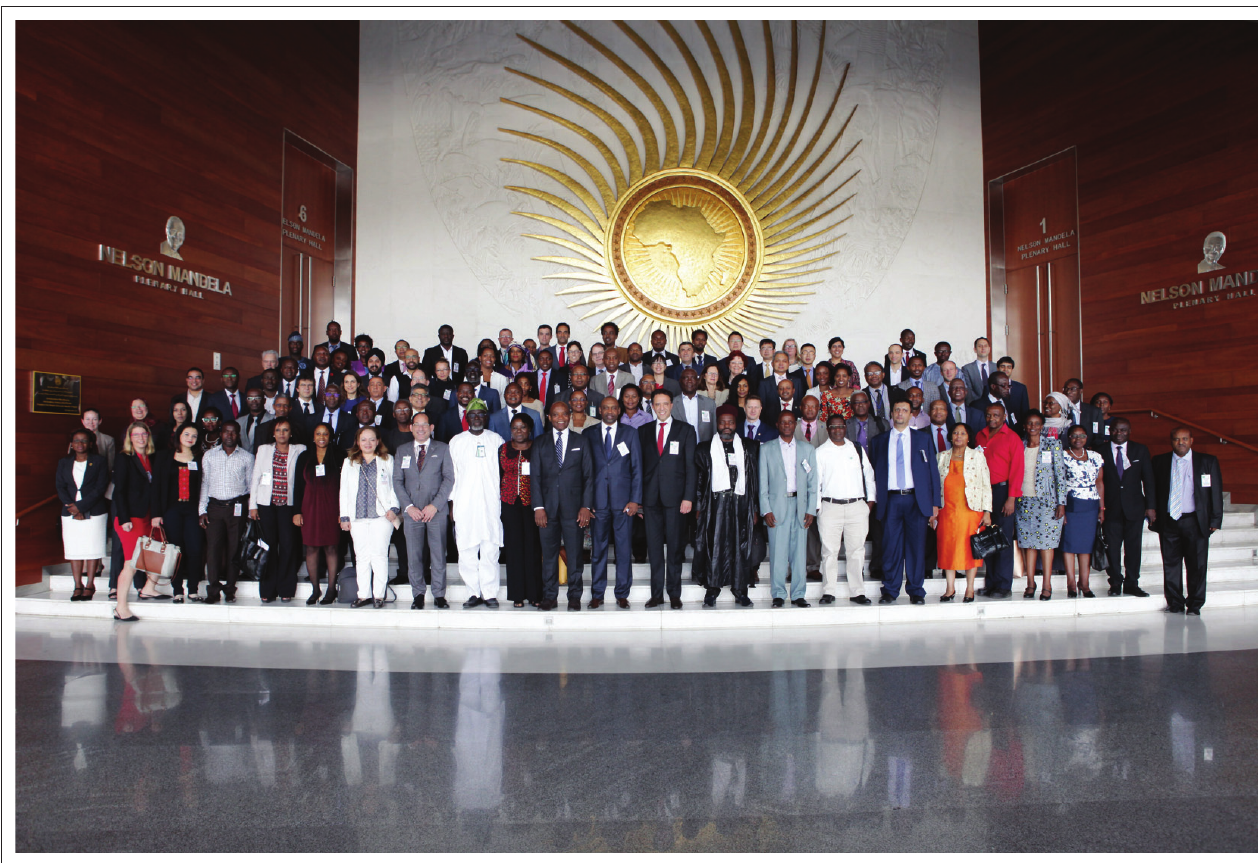
FIGURE 1: Attendees of the ‘Innovative Approaches to Establishing and Strengthening Regional Integrated Surveillance and Laboratory Networks for Disease Control, Prevention, and Clinical Care’ workshop. The workshop was jointly supported by the Africa CDC, the World Health Organization, and the African Society for Laboratory Medicine, and included participants from both the private and public sectors with a role in the laboratory sector in